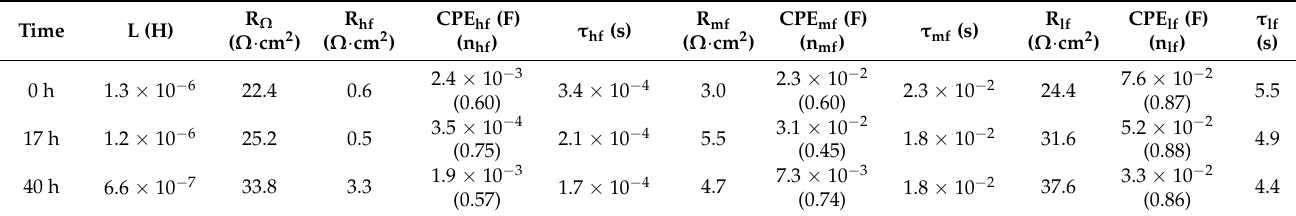
Figure 1. Electrochemical measurement at 550 °C of the cell sintered at 1380 °C at t = 0, 17 and 40 h ( a ) Nyquist plots, the numbers reported in the figure indicate the log of the frequency; ( b ) Bode plots; and ( c ) evolution of the electrolyte resistance R Ω and of the single contributions to polarization resistance R p over time. Table 2. Fitted elements and mean time constants of the three semicircles.